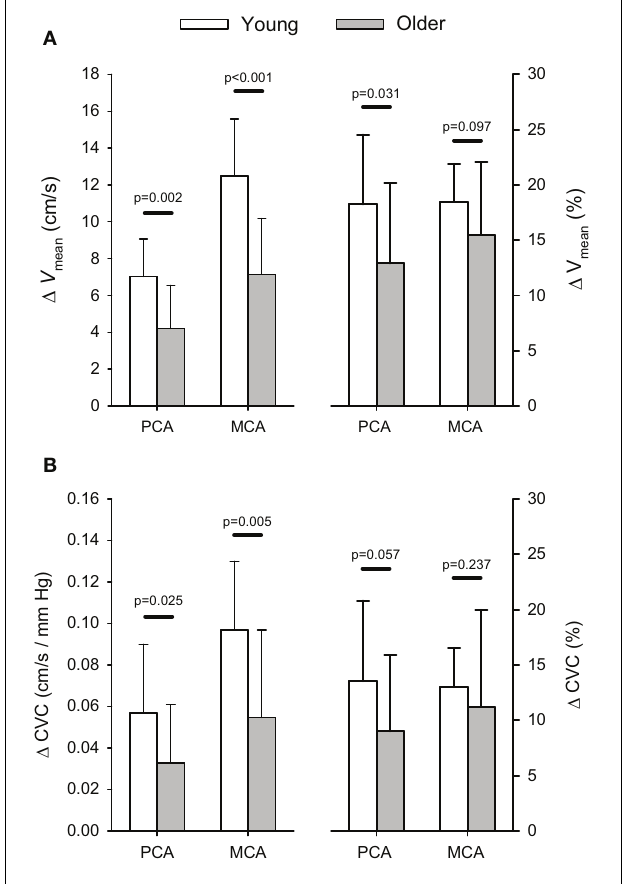
FIGURE 2 | Absolute (cm/s) and relative (%) changes ( (cid:2) ) in posterior (PCA) and middle cerebral artery (MCA) blood velocity (A) and cerebrovascular conductance (B) in response to visual stimulation. P -values provided for comparison between young and older volunteers.